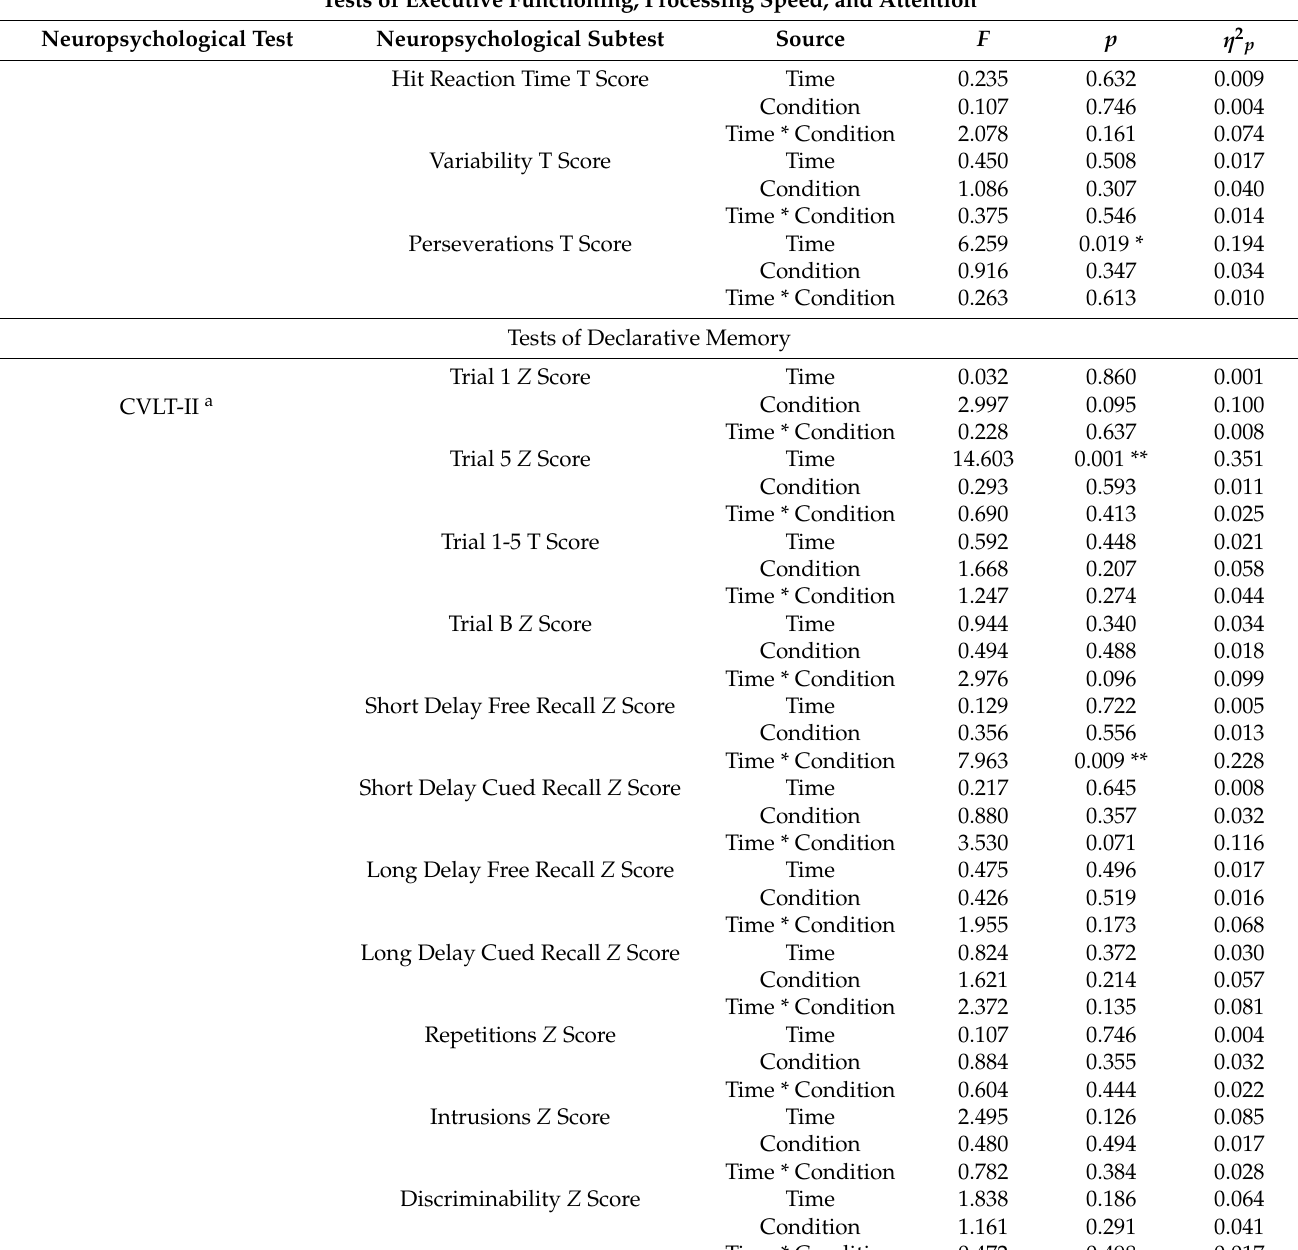
Table 3. Cont. Tests of Executive Functioning, Processing Speed, and Attention